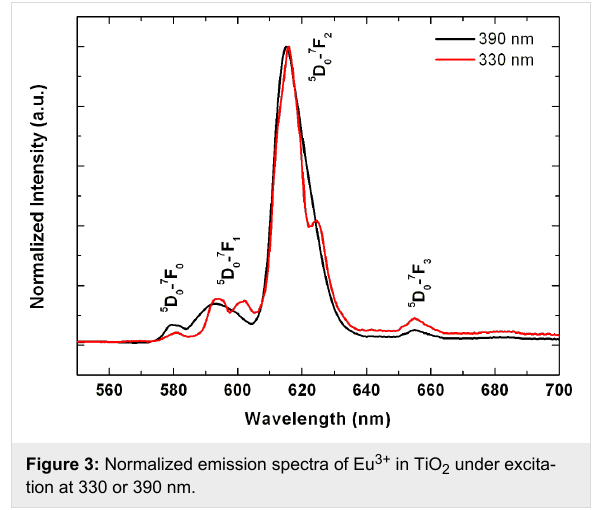
Figure 3: Normalized emission spectra of Eu 3+ in TiO 2 under excita- tion at 330 or 390 nm.